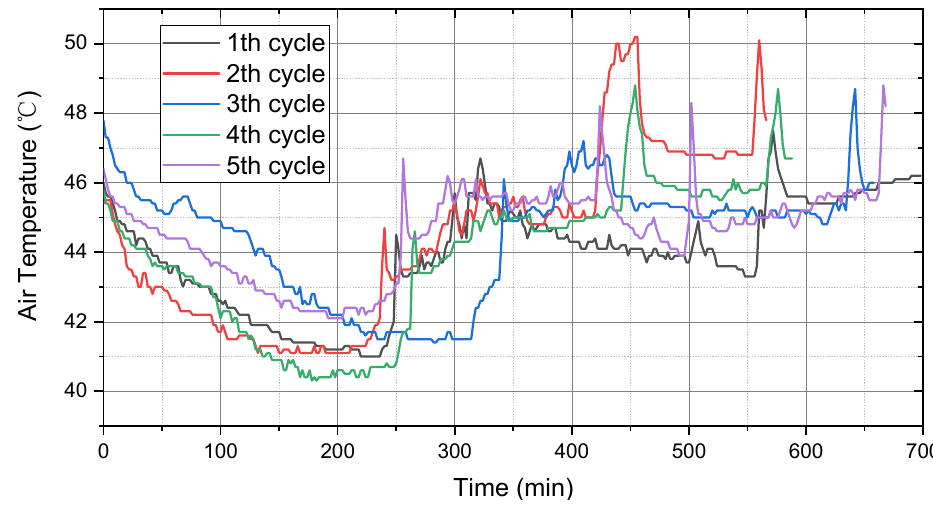
Figure 10. Temperature variation curves of each construction cycle.